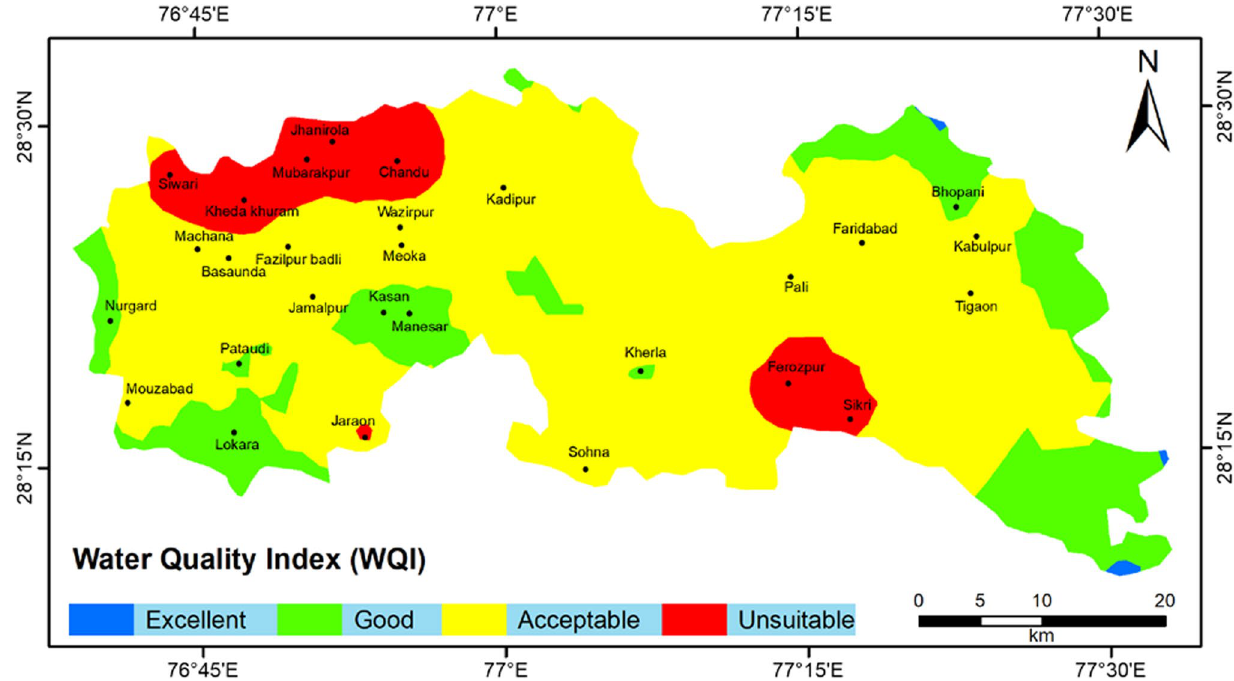
Fig. 5 Spatial distribution map of WQI over the study